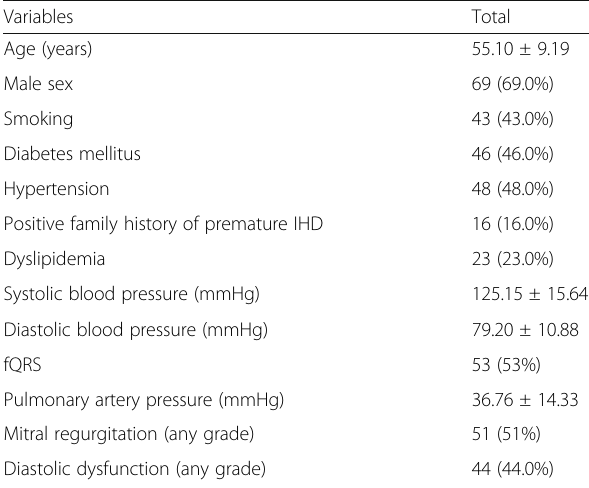
Table 1 Demographic, clinical, ECG, and echocardiographic data of our study population